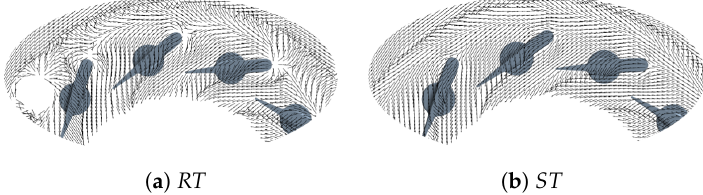
Figure 9. Flow direction over the tip. ST and RT; VGT60; 0.5 mm tip height.